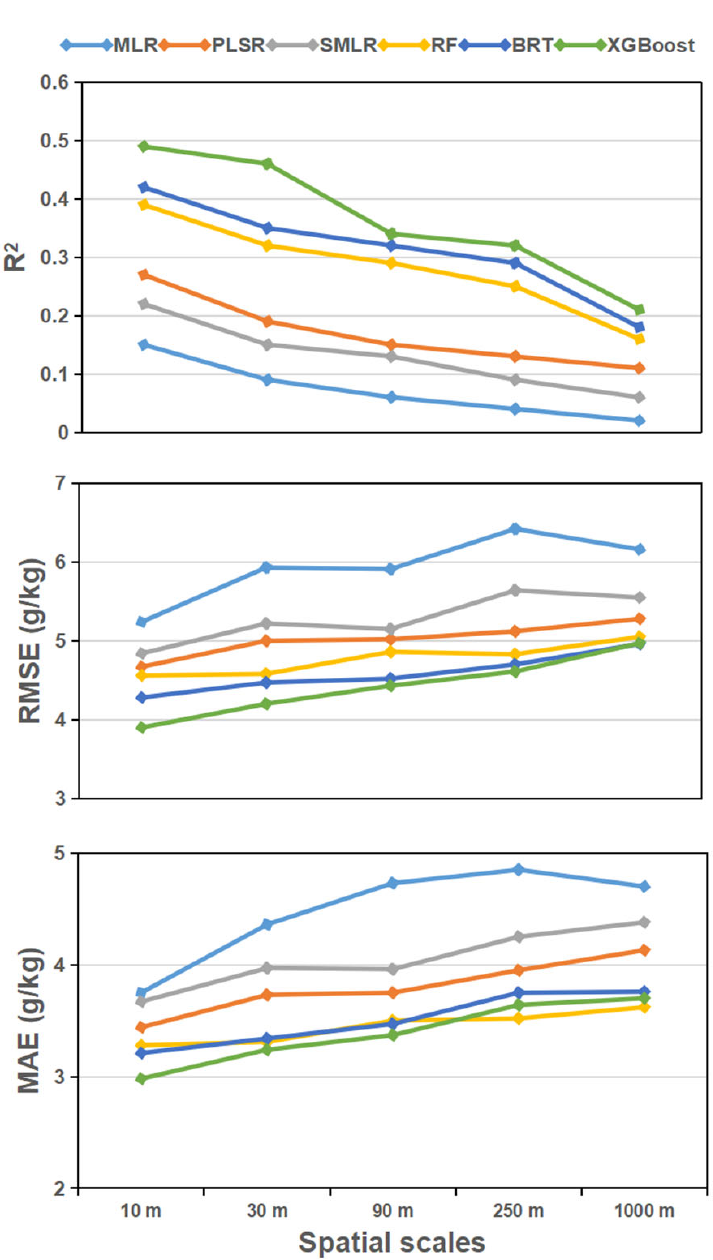
Figure 5. Accuracy comparison of models under five spatial scales.